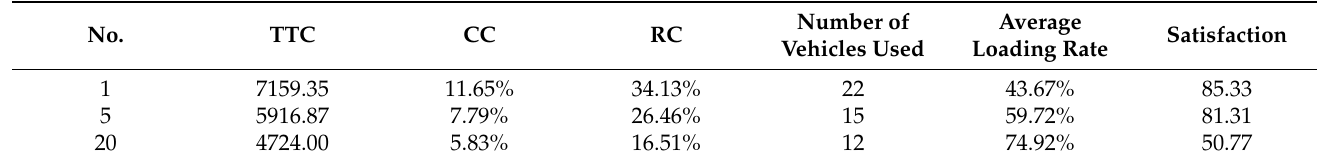
Table 5. Comparison of selected solution and optimal